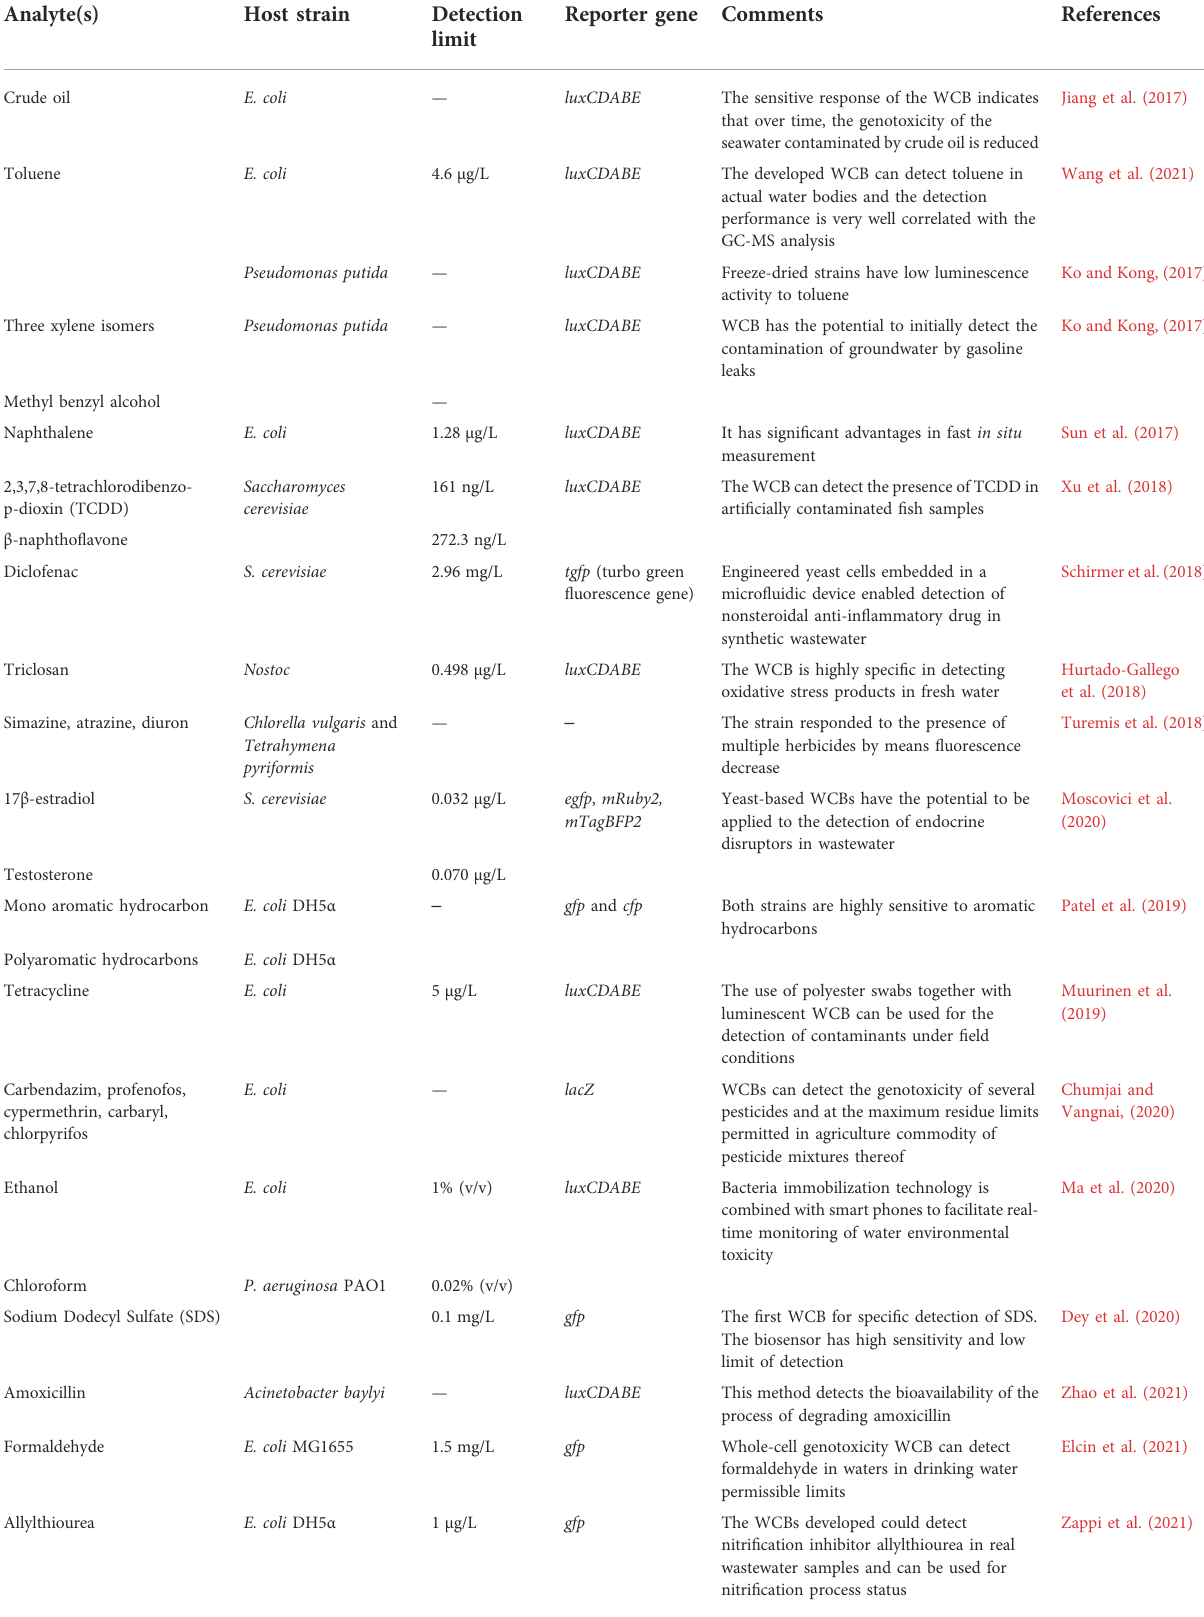
TABLE 1 Whole-cell bioreporters used in the detection of organic